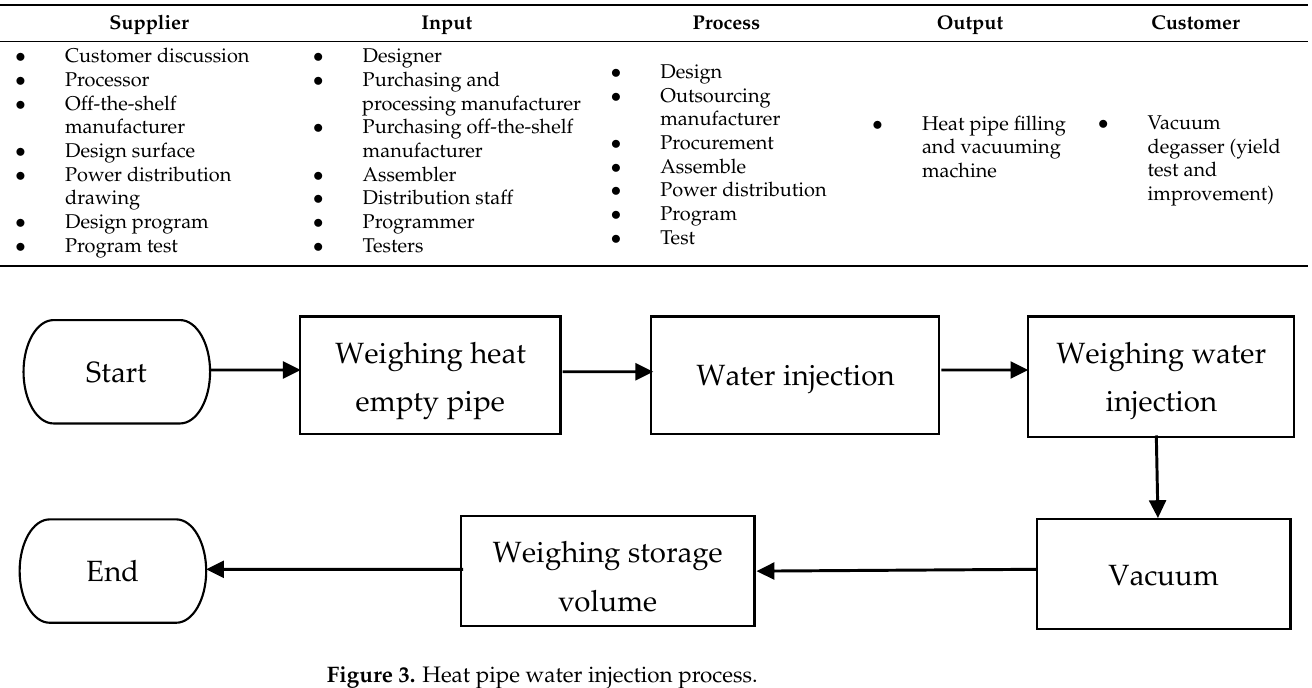
Table 2. SIPOC diagram.